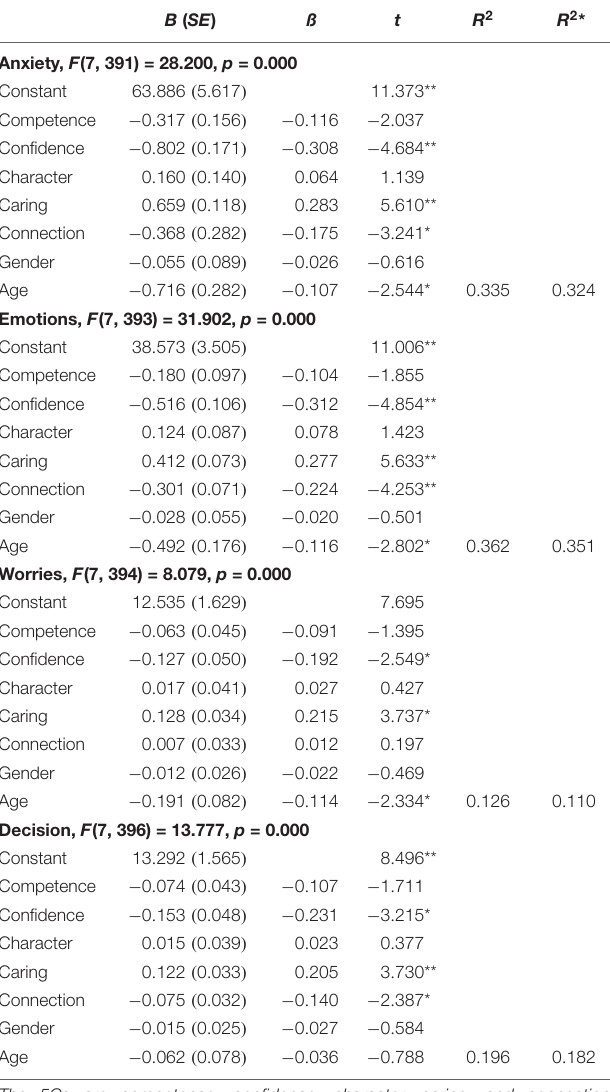
TABLE 4 | The predictive power of the global PYD factor and 5Cs for anxiety and its components in Slovenian